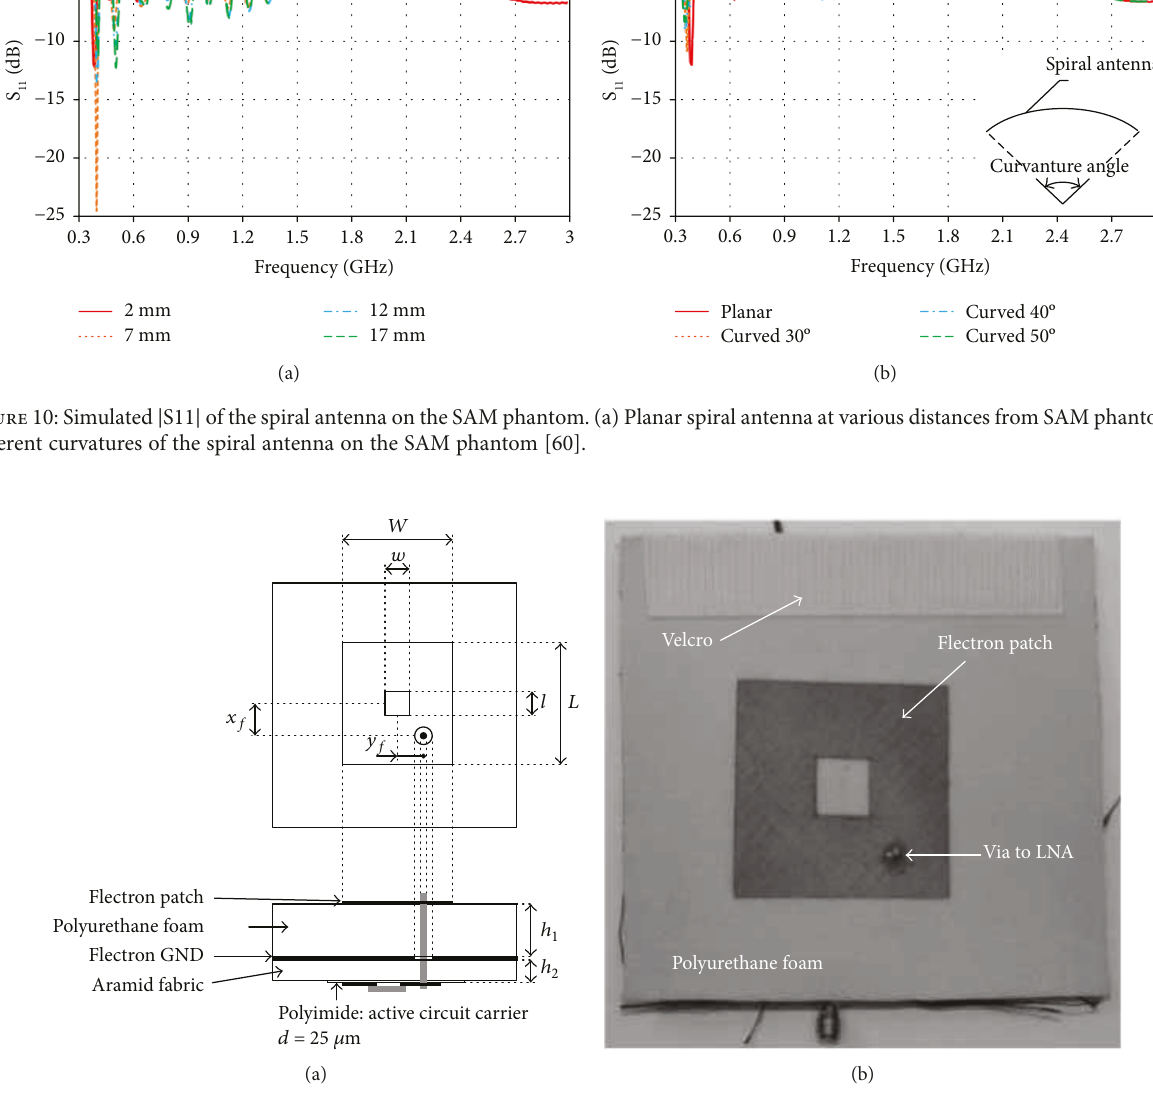
Figure 11: (a) Geometry of the active receiving wearable antenna. (b) Top view of the active receiving antenna